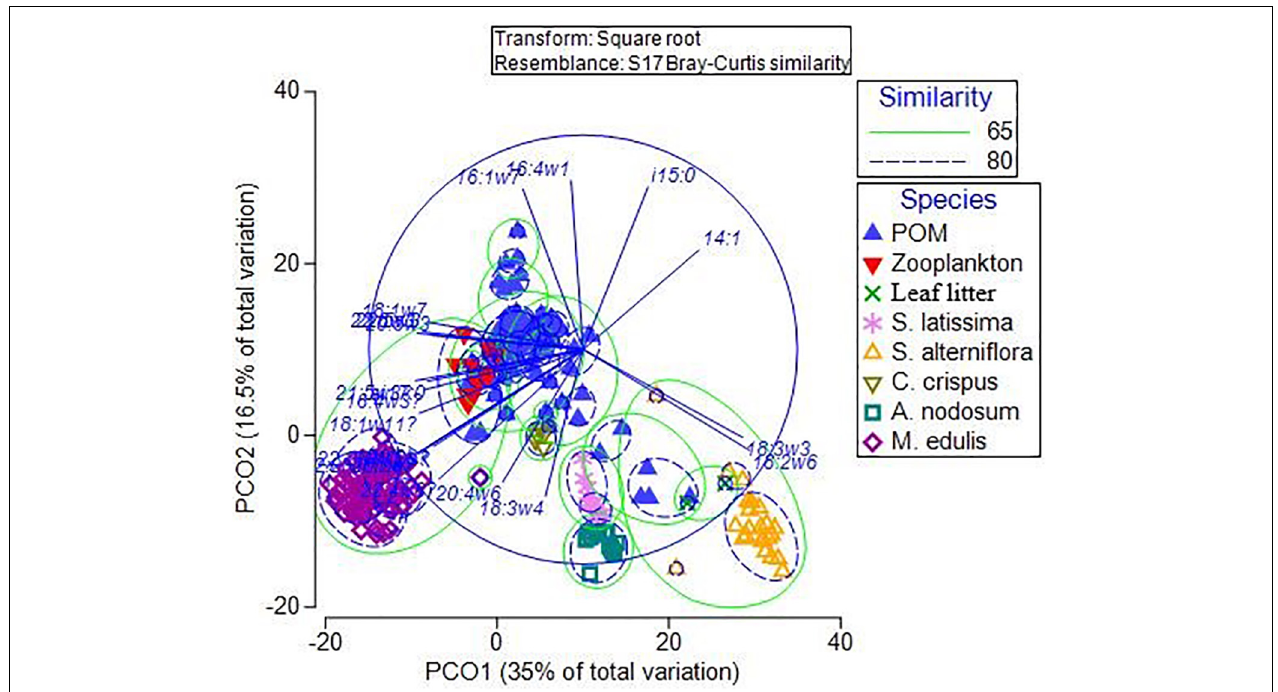
FIGURE 8 | Principal coordinates analysis of fatty acids in < 100 µ m particulate organic matter (POM), zooplankton, leaf litter, Spartina alterniflora , Saccharina latissima , Ascophyllum nodosum , Chondrus crispus and Mytilus edulis from Saco Bay, ME, United States, throughout 2016 and 2017. Circled groupings are based on similarity (%) determined from similarity percentage analysis (SIMPER) and cluster